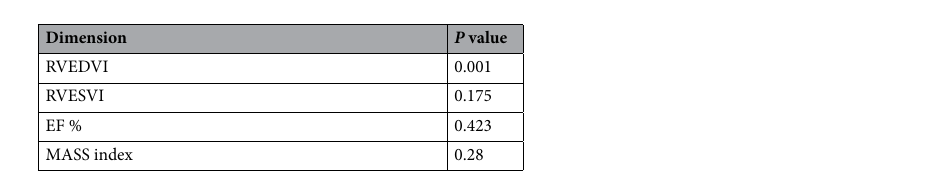
Table 5. Comparison between increment of CMR values among sex (only studies with both male and female data were shown separately).